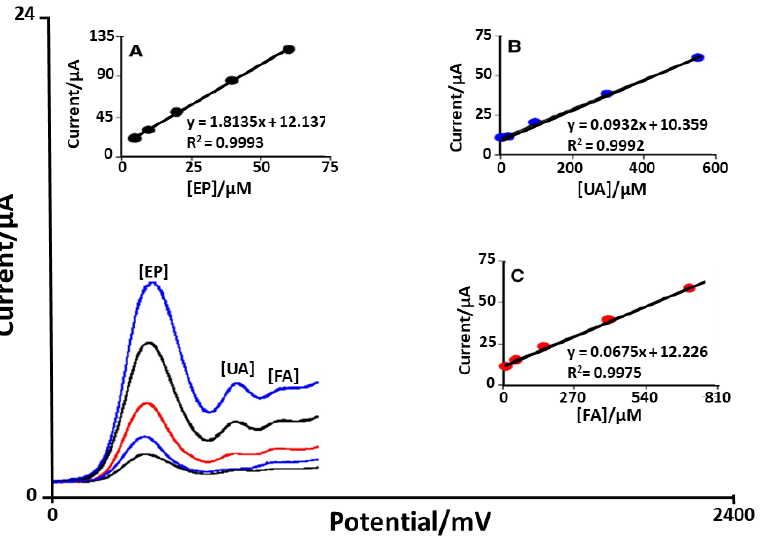
Figure 2. ( A ) SWVs of 2FTNEMCNPPE in 0.1 M PBS (pH 7.0) with various concentrations ( μ mol L − 1 ) of EP, UA FA in a mixed solution: (1) 5.0 + 5.0 + 10.0, (2) 50.0 + 25.0 + 10.0, (3) 150.0 + 100.0 + 20.0, (4) 400.0 + 300.0 + 40.0, (5) 700.0 + 550.0 + 60.0. ( A – C ): plots of peak currents as a function of EP, UA and FA concentration, respectively [50].